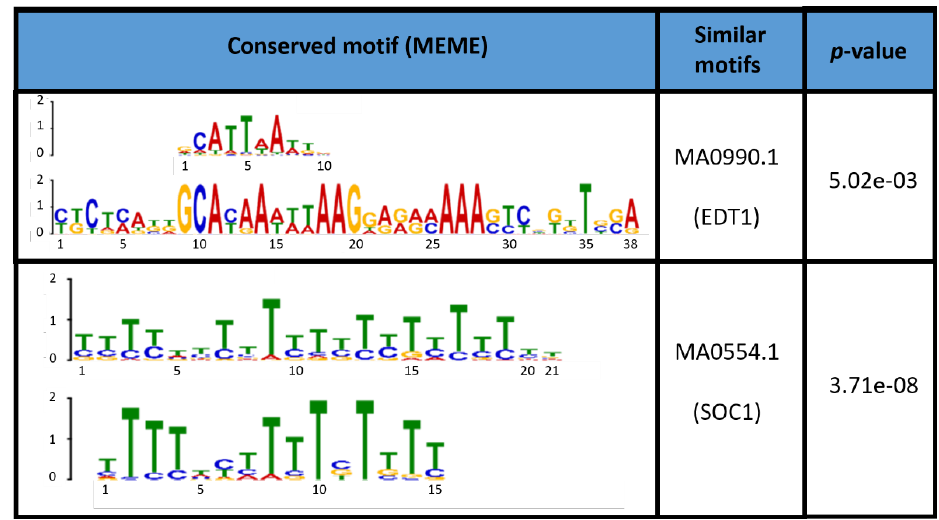
Figure 3. Conserved motifs in the promoters of the seven DUF642 genes from M. truncatula . The 1000 bp upstream of the start codon were analyzed using the MEME suite 4.11.2. The first motif in each table cell is the one found in the database; the second motif is the one found in the promoters of alfalfa genes. The p -values are indicated.